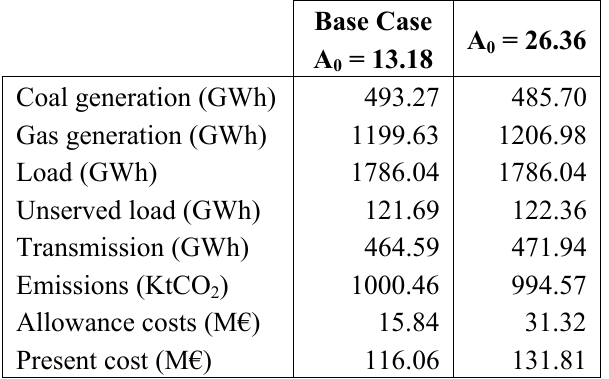
Table 7. Average generation, load, transmission, and costs ( 1 L ): Base case vs. higher allowance price.